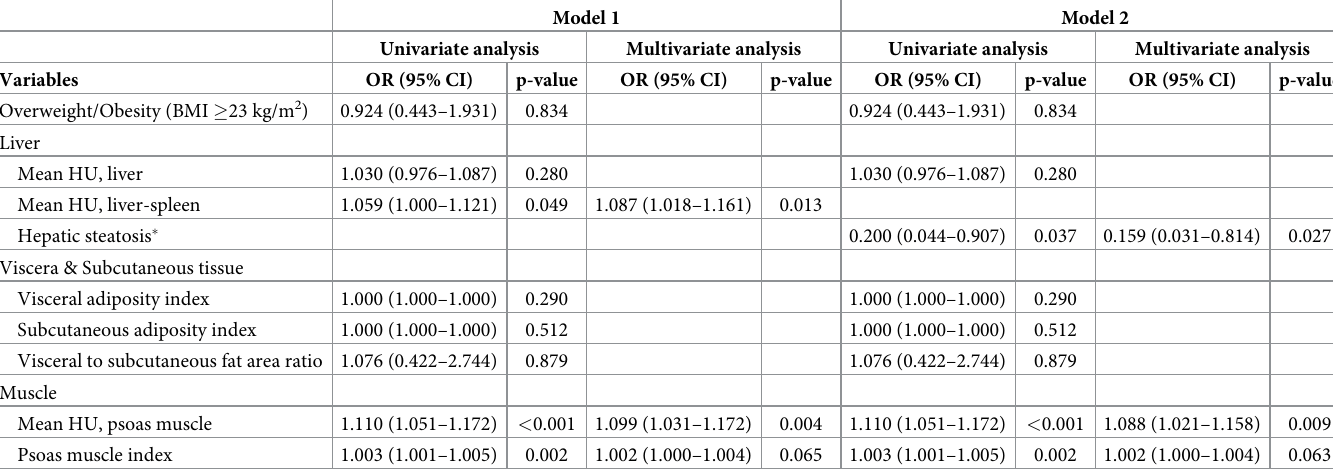
Table 4. Variables associated with elevated AFP > 7 ng/mL in patients with